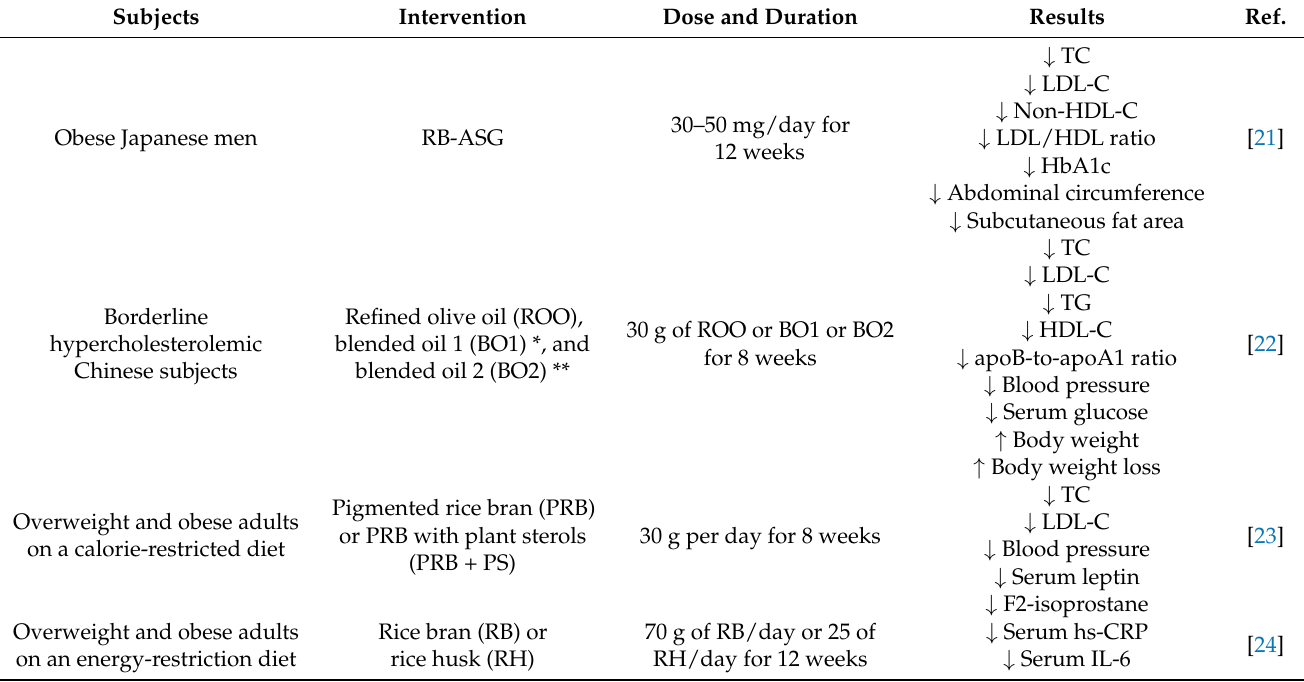
Table 3. Effects of rice bran supplementation on obesity-associated biomarkers: Results of clinical